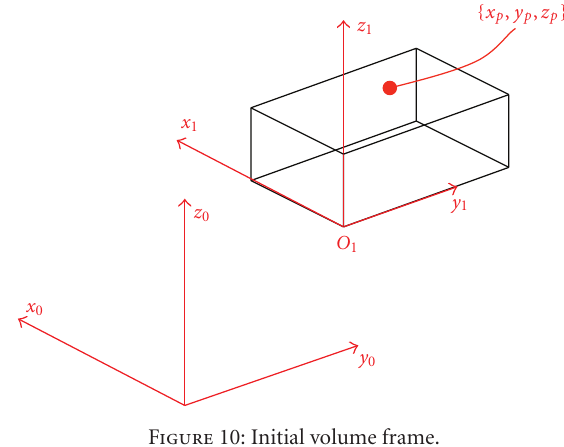
Figure 10: Initial volume frame.